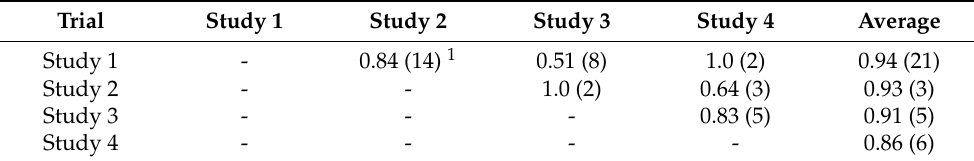
Table 2. Pearson’s correlation between perennial ryegrass variety residual grazed height, evaluated in separately sown plot evaluations (differing sowing years) and the average residual grazed height value for each variety across all trials.